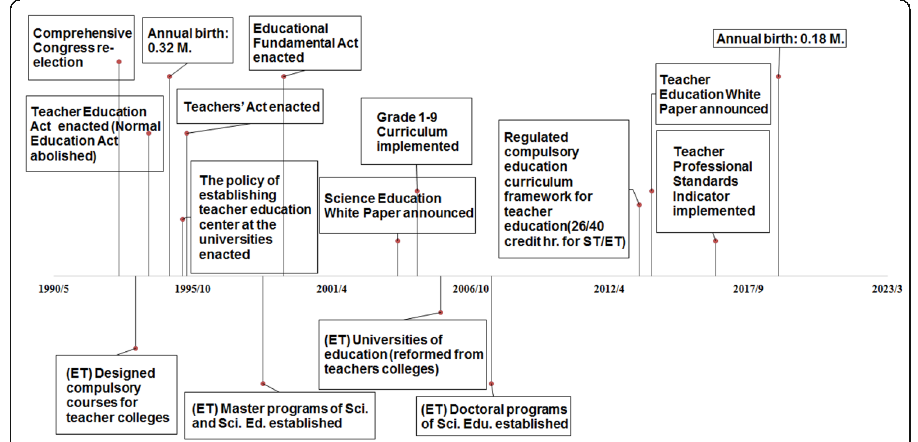
Fig. 2 The historical landmarks during the immediate past stag (IPs): 1994 – 2017 (ST: secondary teacher; ET: elementary